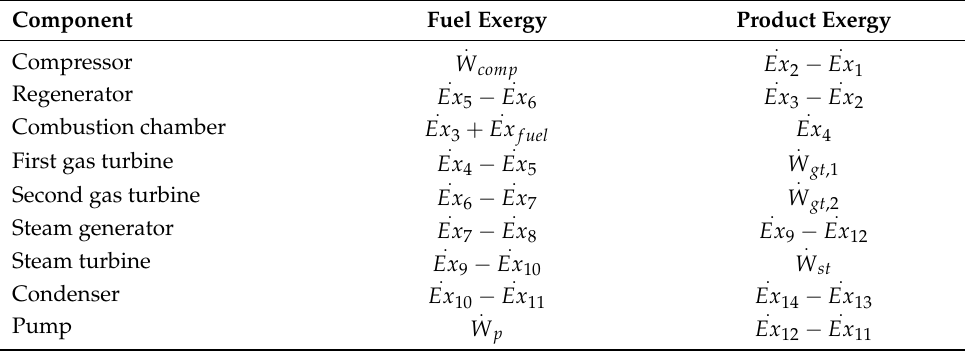
Table 3. Fuel and product exergy in various components of Figure